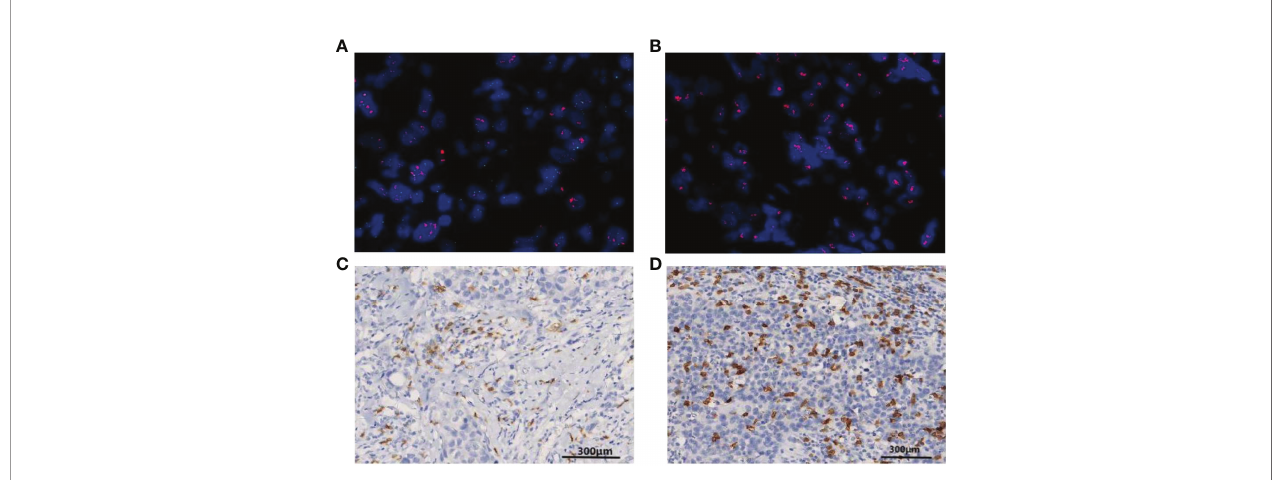
FIGURE 2 | Fluorescence in situ hybridization (FISH) is shown for HER2 gene ampli fi cation in specimens and in corresponding histological sections (HER2, red signal; CEP17, green signal). (A) A patient with positive HER2 ampli fi cation status of a HER2/CEP17 ratio <8. (B) A patient with positive HER2 ampli fi cation status of a HER2/CEP17 ratio ≥ 8. (C) Patterns of CD8+ T-lymphocyte IHC staining >10% CD8 IHC staining (100× magni fi cation). (D) More than 20% CD8 IHC staining (100× magni fi